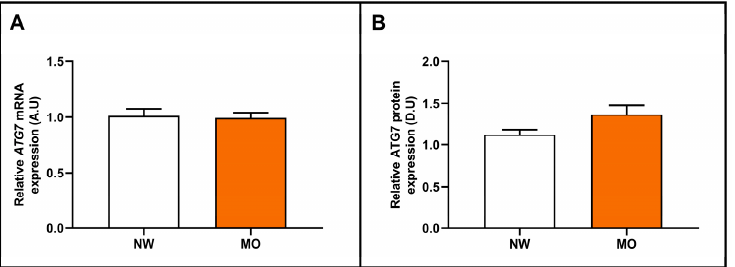
Figure 2. Differential relative ATG7 mRNA ( A ) and ATG7 protein ( B ) abundance in liver samples between women with NW and MO. mRNA expression analysis: NW ( n = 6) and MO ( n = 72); and protein expression analysis: NW ( n = 5) and MO ( n = 16). NW, normal weight; MO, morbid obesity; ATG7 /ATG7, autophagy-related 7 gene/protein; A.U, arbitrary units; D.U, densitometry units. Differences between groups were calculated using the Mann–Whitney test and p < 0.05 was considered statistically significant.